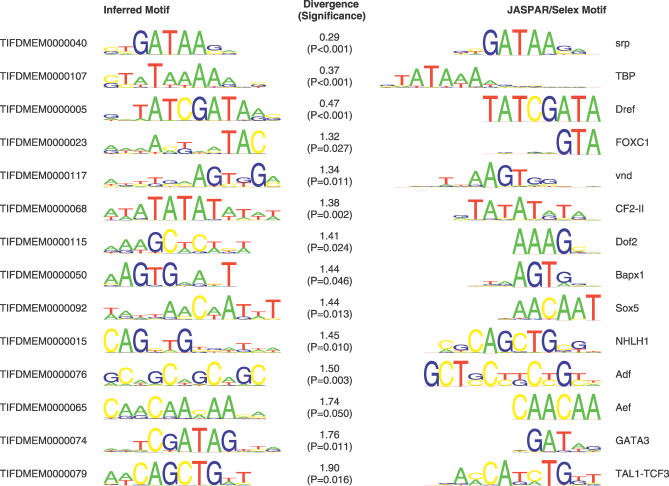
Statistically Significant Best Reciprocal Matches between 120 Discovered Motifs and Motifs from Extended JASPAR CORE